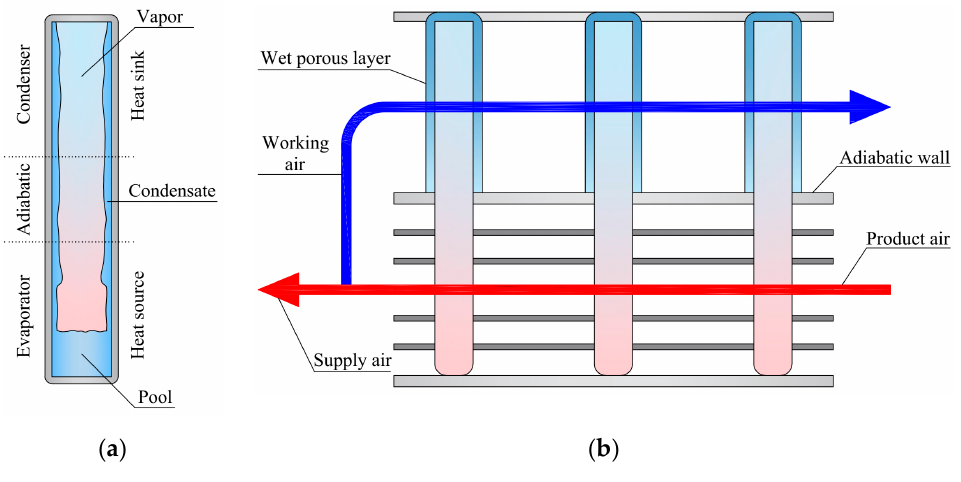
Figure 1. Visualization of an indirect evaporative cooler (IEC): ( a ) gravity-assisted heat pipe (GAHP); ( b ) airflow arrangement.